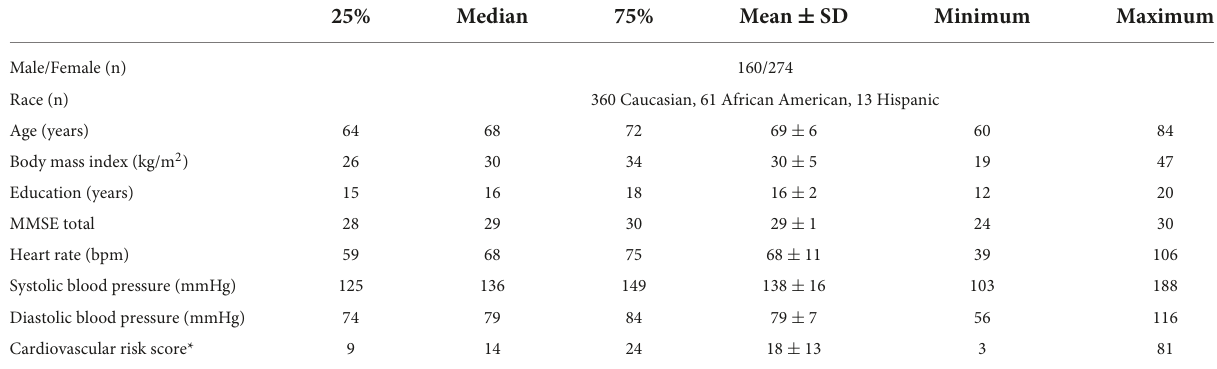
TABLE 1 Participant